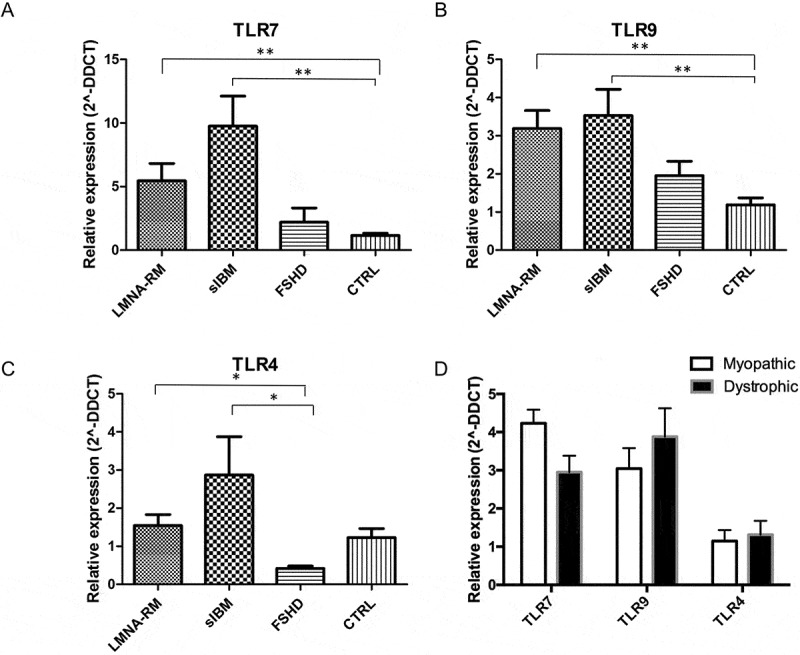
Expression of TLR7, TLR9 and TLR4 in LMNA-RM, sIBM, FSHD patients and non-myopathic controls (CTRL) was quantified by qRT-PCR. (a) and (b) show that TLR7 and TLR9 were significantly up-regulated in LMNA-RM and sIBM, but not in FSHD, compared to controls. (c) TLR4 expression levels were comparable between patients and controls; a statistically significant difference was observed between LMNA-RM and FSHD and between sIBM and FSHD. (d) Comparison between dystrophic and myopathic LMNA-RM patients did not show any significant difference in the mRNA expression levels of the TLRs analysed. Data are represented as mean ± SEM. *p < 0.05, **p < 0.01.